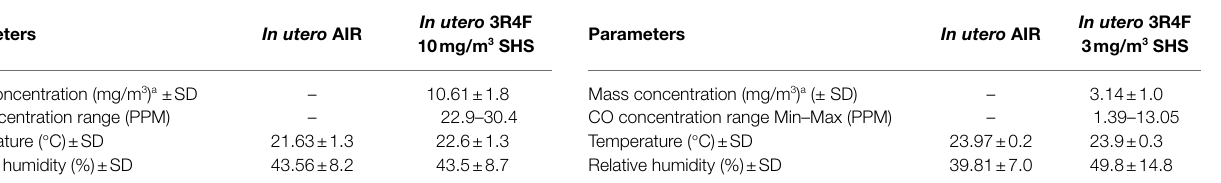
TABLE 2 | In utero SHS + HDM – Asthma